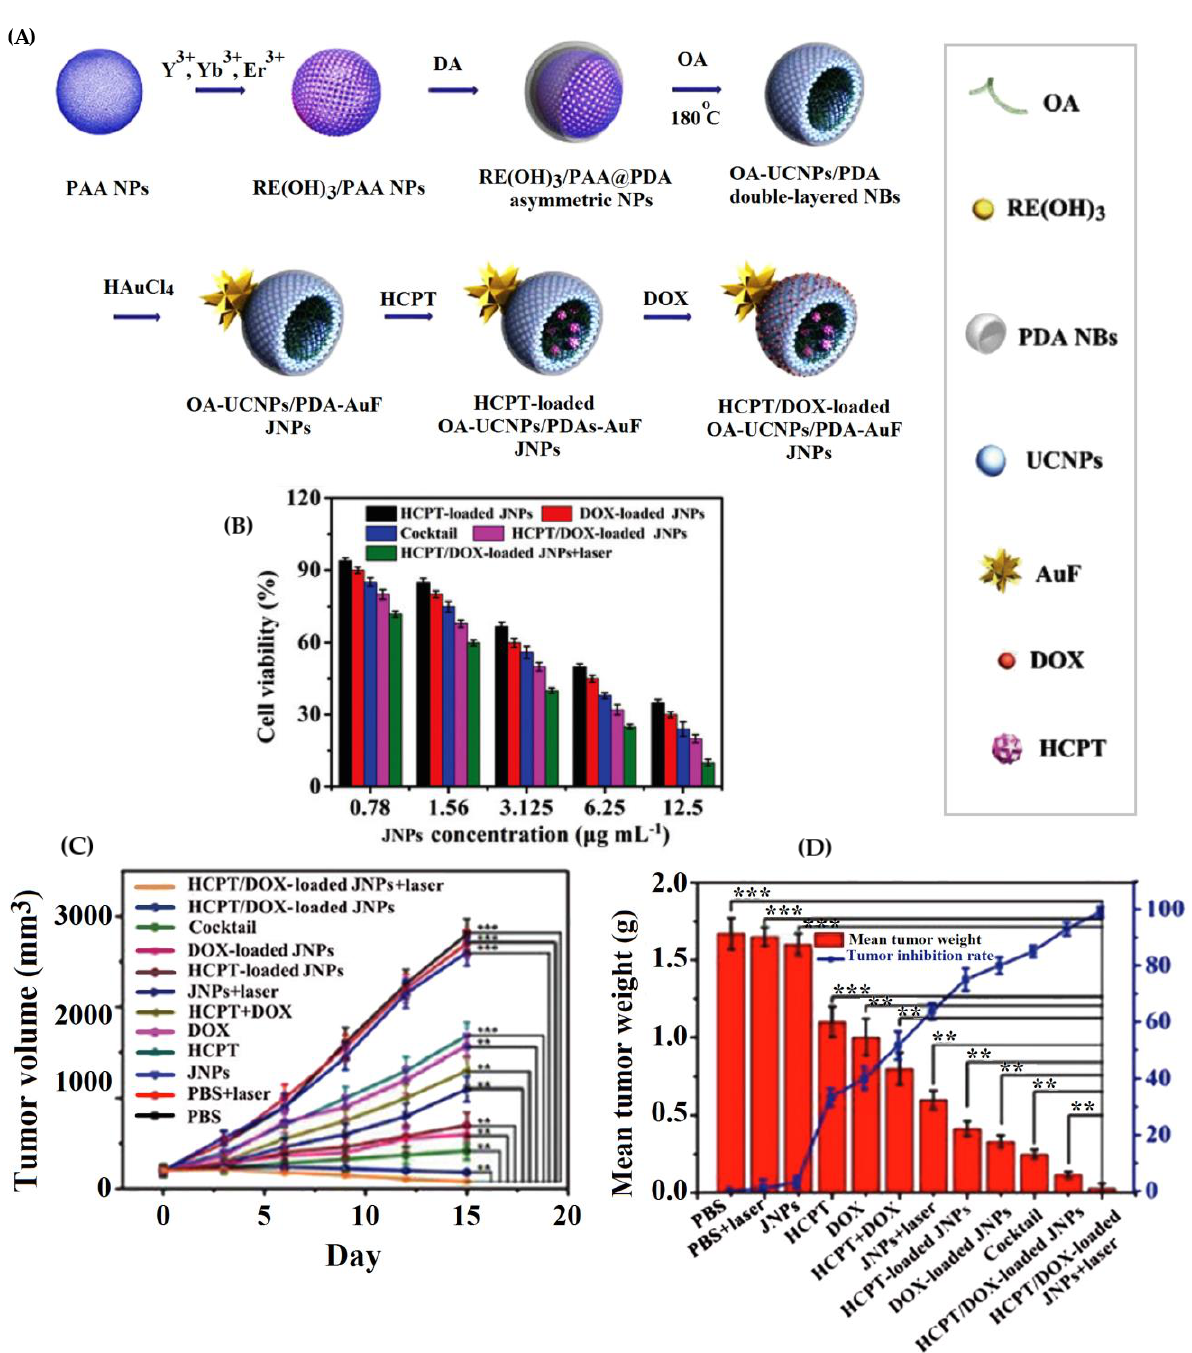
Figure 12. ( A ) Schematic of HCPT/DOX-loaded OA-UCNPs/PDA-AuF JNP synthesis process. ( B ) Cell viability results of test groups attained from MTT assay. ( C ) Tumor growth patterns per day. ( D ) Tumor weight inhibition rate from each test group (** p < 0.01 and *** p < 0.001). Reproduced from Chen et al. [154], with permission from the Royal Society of Chemistry, Great Britain.